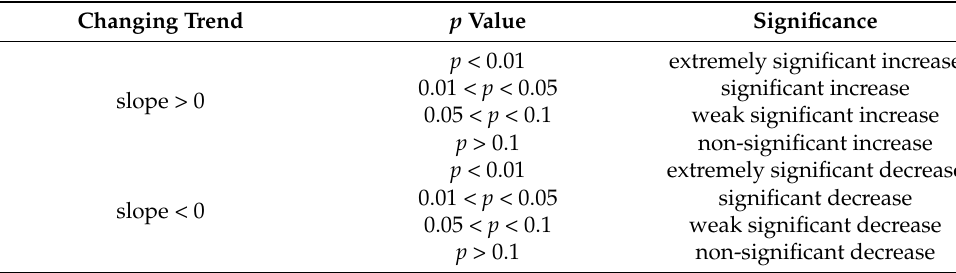
Table 3. Classification of the changing trends and their significances. Changing